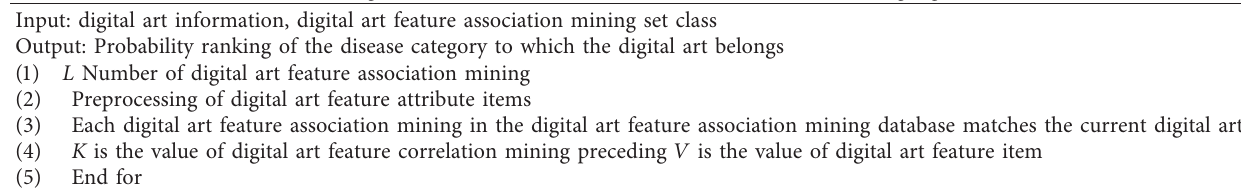
Table 2: Digital art feature association based on the machine learning algorithm.